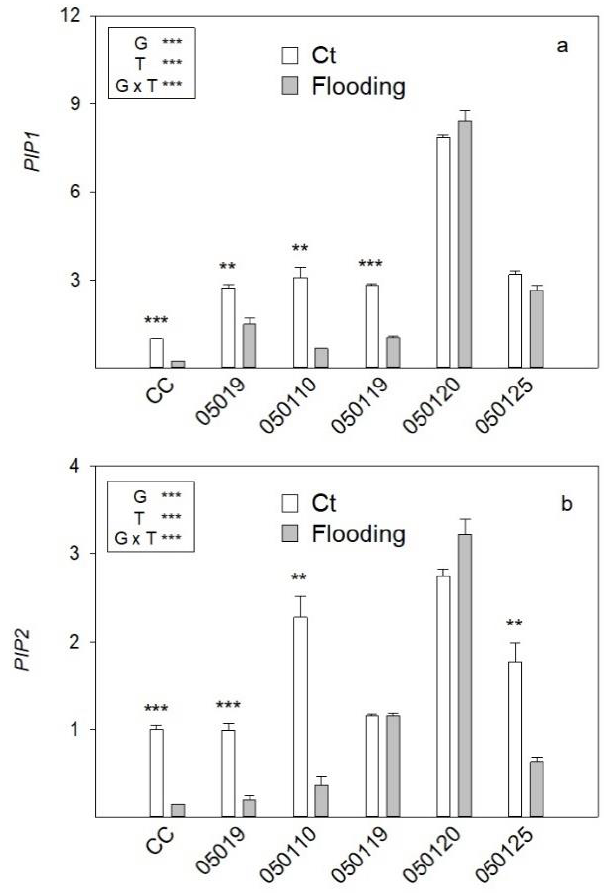
Figure 8. ( a ) PIP1 and ( b ) PIP2 relative expression levels in the roots of five citrus hybrids grown for 35 days in the non-stressed (Ct) or flooding treatment. The values are means of six independent seedlings ( n = 6). In each hybrid, comparisons among treatments were made by Fisher’s least significance difference (LSD) test. ** p < 0.01, *** p < 0.001. CC: Carrizo citrange; G: genotype, T: treatment.